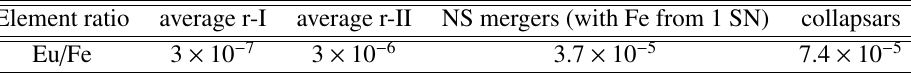
Table 2. Candidates for category CIIIa and CIIIb events for complete r-process stars of regime 3 Element ratio average r-I average r-II NS mergers (with Fe from 1